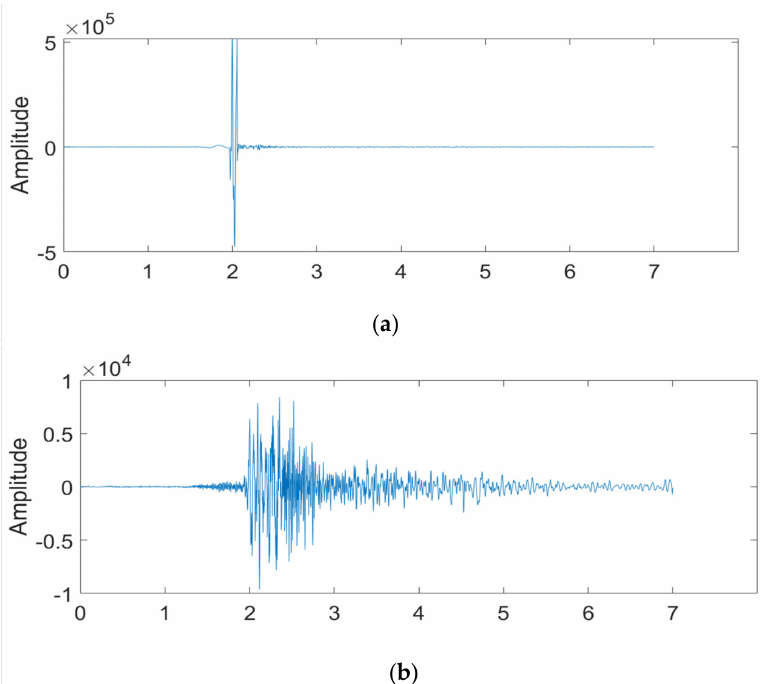
Figure 17. 501th trace outlier point analysis. ( a ) Raw data. ( b ) The amplitude after outlier noise suppression.